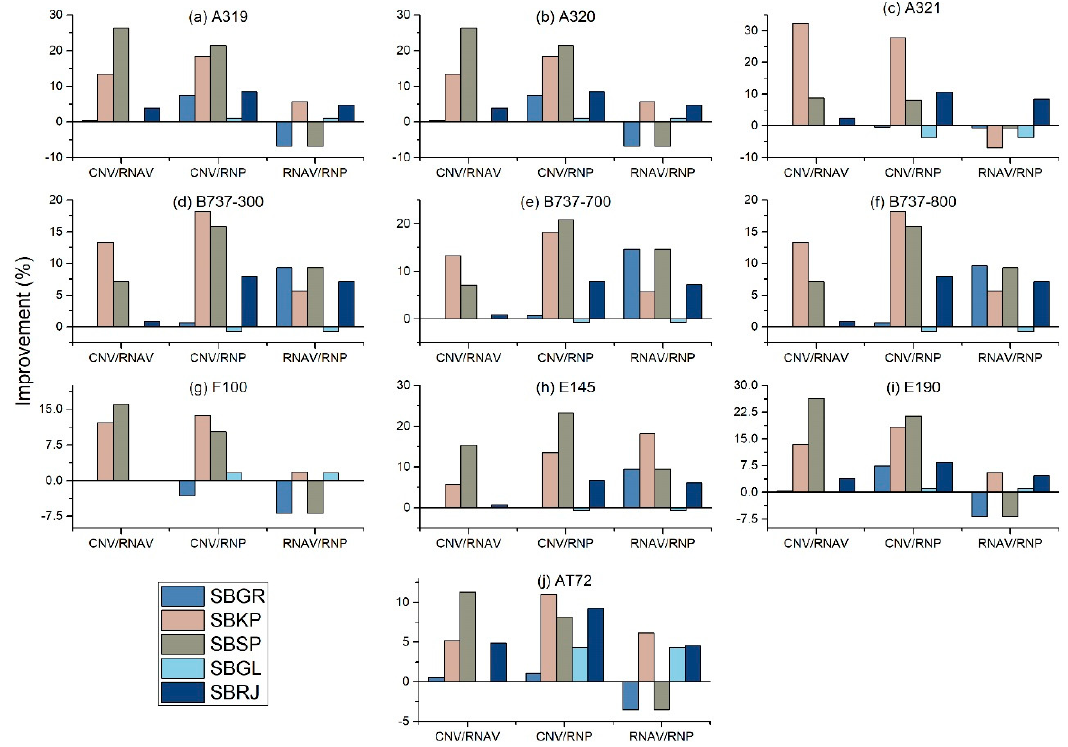
Figure 7. Case 1 approach; percentage improvement by aircraft. ( a ) A319; ( b ) A320; ( c ) A321; ( d ) B737-300; ( e ) B737-700; ( f ) B737-800; ( g ) F100; ( h ) E145; ( i ) E190; ( j ) AT72.